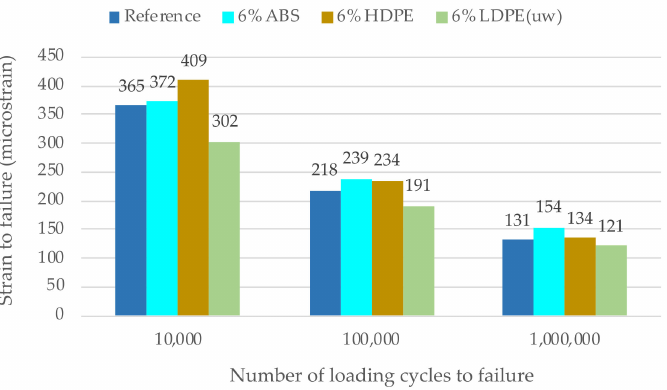
Figure 11. Comparison of tensile strain at 10,000, 100,000, and 1 million loading cycles used as a fatigue resistance indicator at 20 ◦ C.